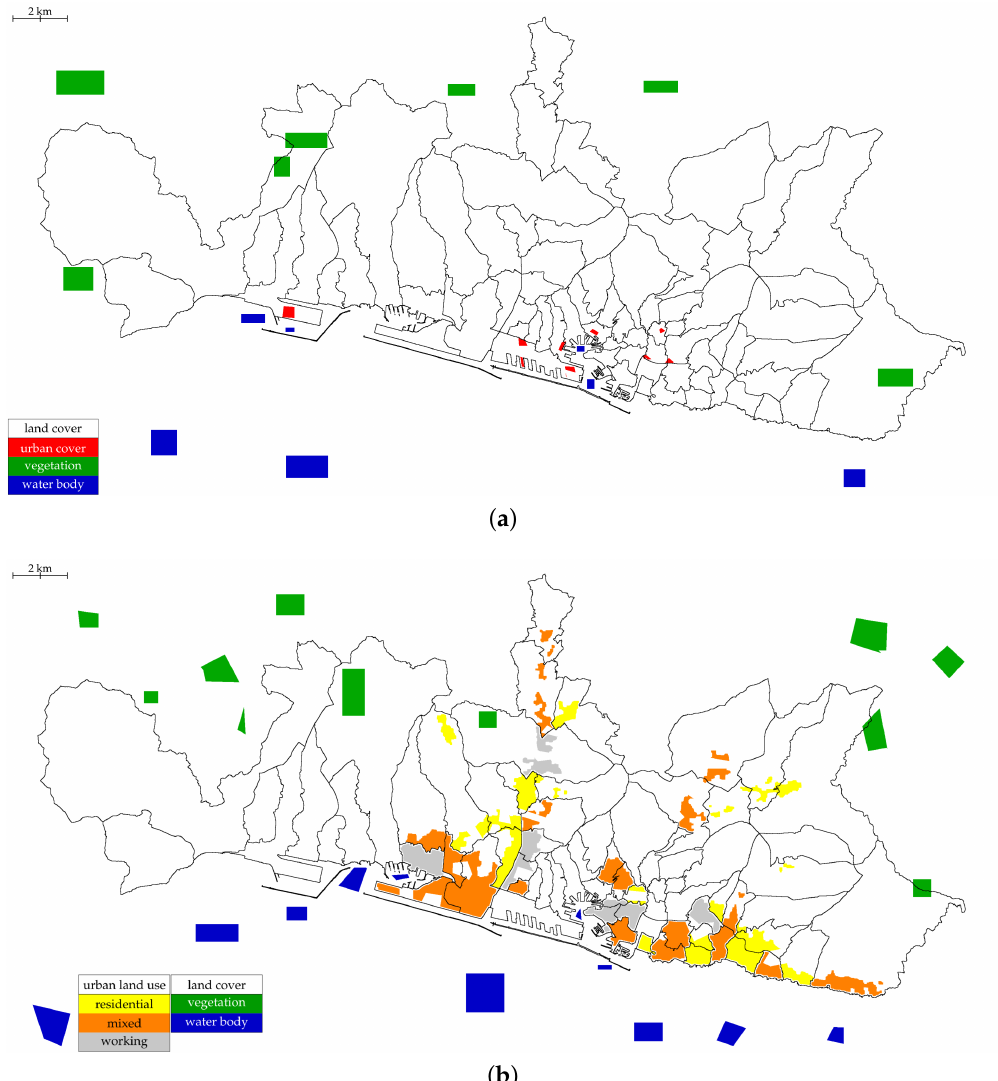
Figure 8. ( a ) Training map for the land-cover classes (including the urban cover) in the proposed fusion methods and ( b ) test map for quantitative accuracy